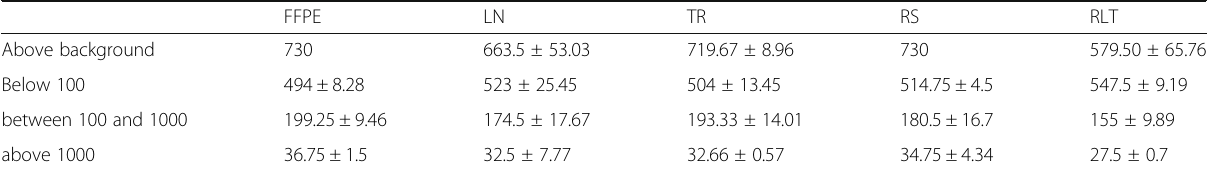
Table 2 Immune gene expression counts above background, below 100, between 100 and 1000 and above 1000 by mRNA extraction method. Values presented are mean counts ± standard deviation of the four processing storage methods. No counts could be determined from the saline